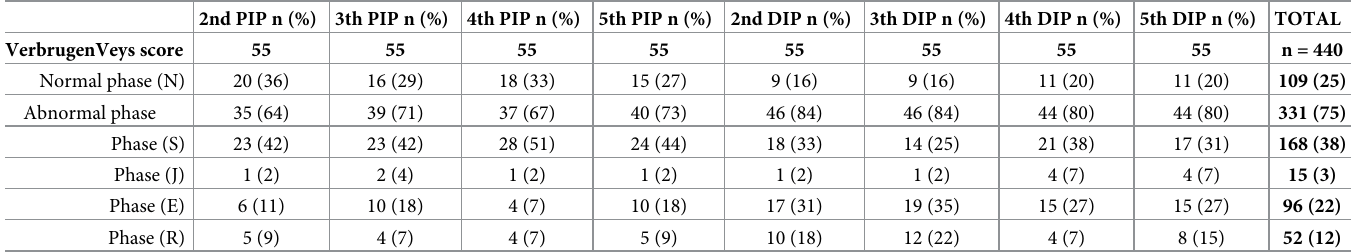
Table 2. The prevalence of Verbruggen-Veys radiographic scoring system features in interphalangeal joints of 2th–5th fingers.